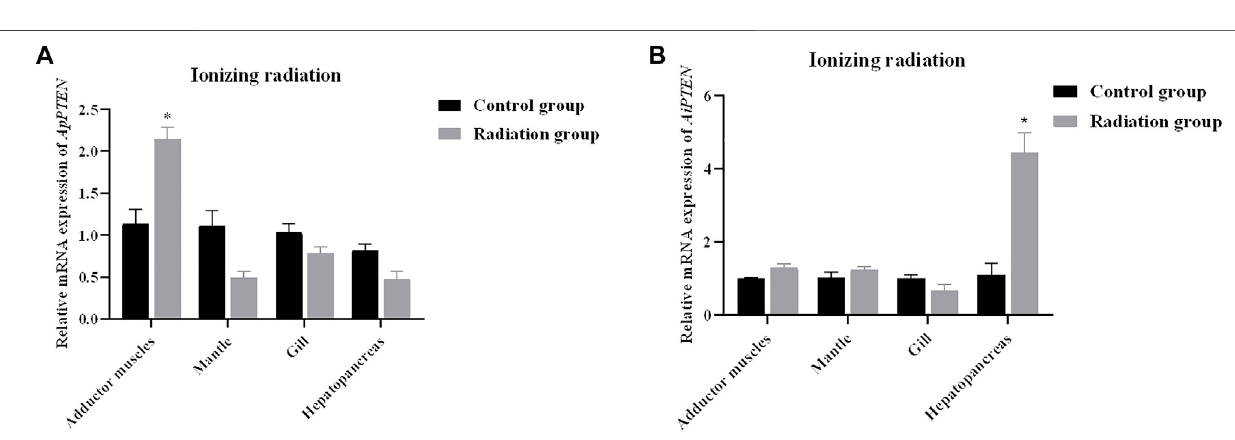
Frontiers in Physiology |